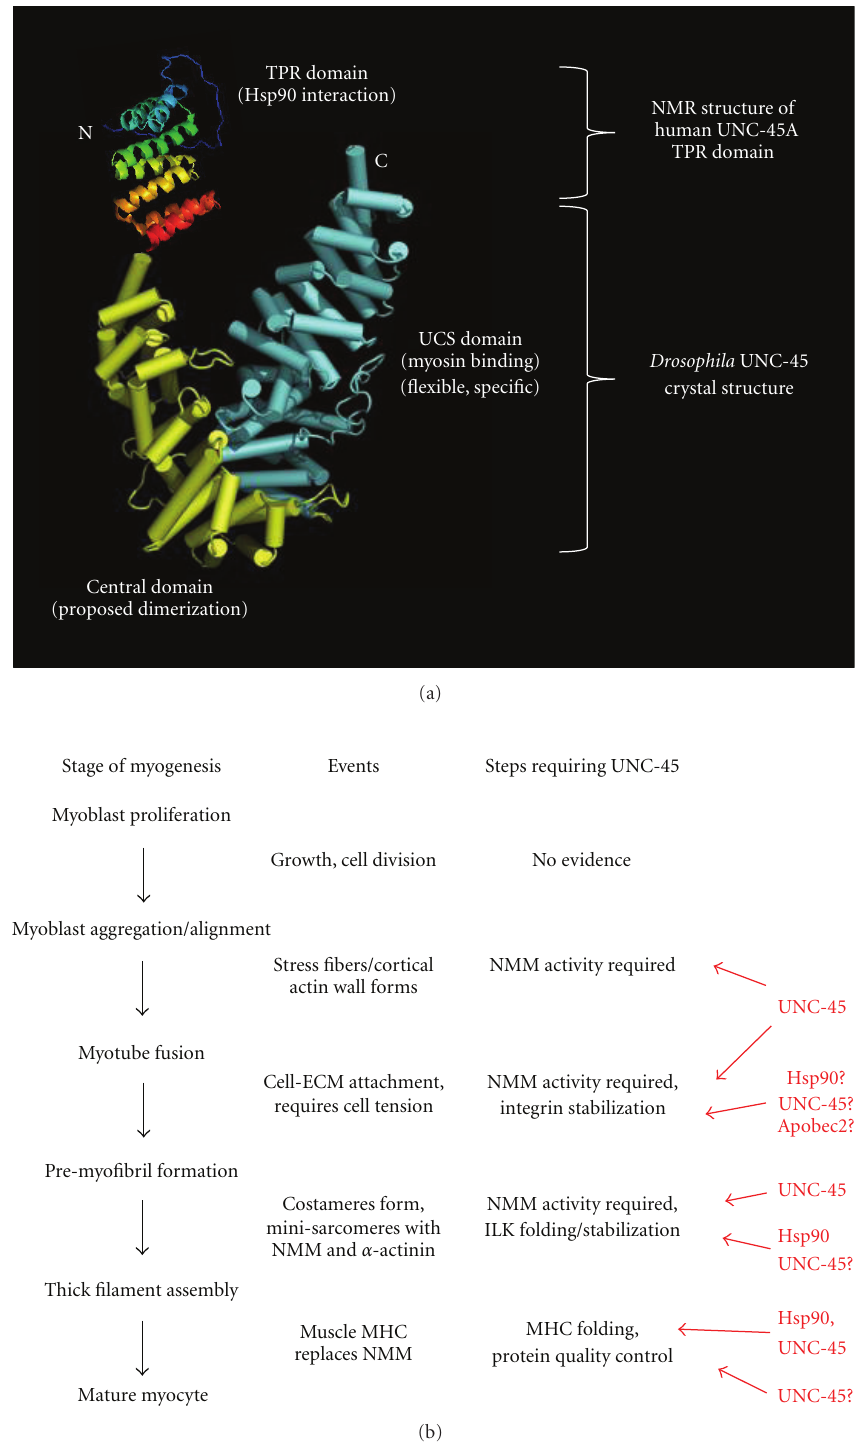
Figure 4: Proposed model of roles for Unc45b/nonmuscle myosin during early myofibrillogenesis. (a) Merged protein model of Unc-45b from the X-ray crystal structure of Drosophila UNC-45 and the solved NMR structure of the human Unc45a TPR domain (protein database ID 2DBA), showing the known active domains. Proposed functions of each section of the protein are indicated. Modified from Lee et al. [139]. (b) Flowchart of myofibrillogenesis, listing the stages where there is significant evidence to hypothesize the involvement of UNC- 45. Events that likely involve UNC-45 chaperone function at each stage of myogenesis are noted, and probable cofactors for UNC-45 are indicated in